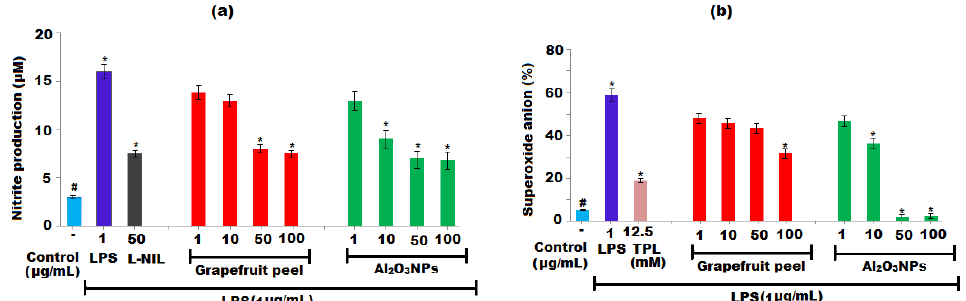
Figure 6. Cellular viability measurements of RAW 264.7, L929, and MV3 cancer cells after 24 h treatment with ( a ) grapefruit peel extract and ( b ) Al 2 O 3 nanoparticles. Values are represented as cellular viability percentage and expressed as the means ± SD of three independent experiments. * Statistically significant ( p < 0.05) as compared to the control cells.